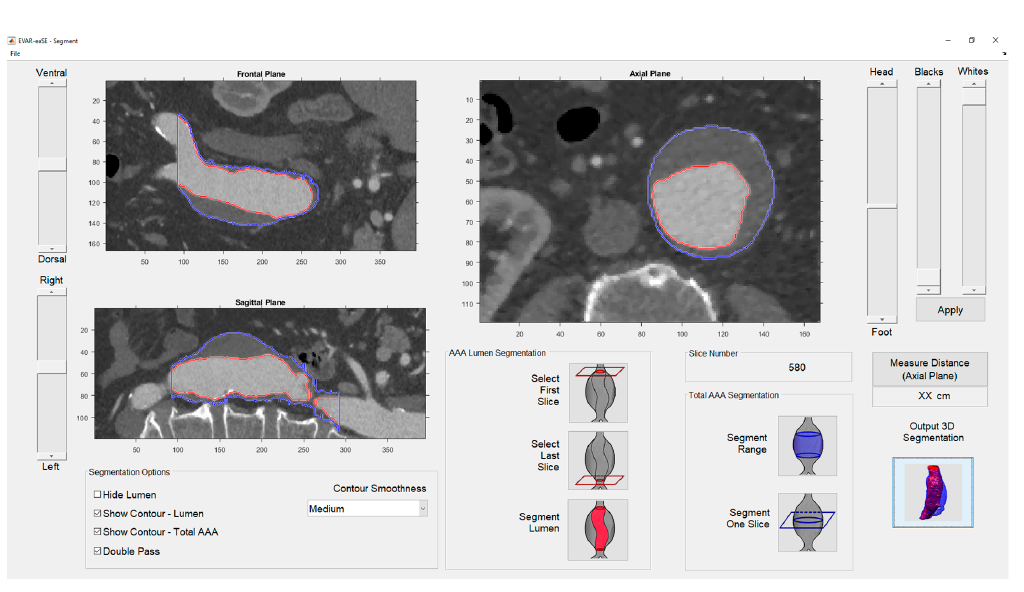
Figure 3. Graphical user interface of Segmentation Window (SW).